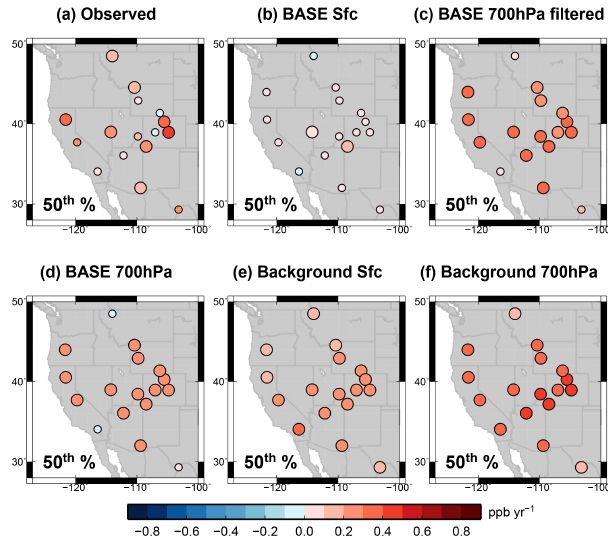
Figure 3. Influence of baseline sampling. Median spring MDA8 O 3 trends over 1988–2014 at WUS sites from (a) observations, (b) BASE model sampled at the surface, (c) BASE sampled at 700hPa and filtered to remove the influence from fresh local pol- lution (see Sect. 2.4), (d) BASE sampled at 700hPa without fil- tering, and (e–f) Background (with North American anthropogenic emissions shut off) sampled at the surface versus at 700hPa. Note that three low-elevation (<1.5km) sites, Joshua Tree, Big Bend and Glacier national parks, are always sampled at the surface. Larger circles indicate sites with statistically significant trends ( p